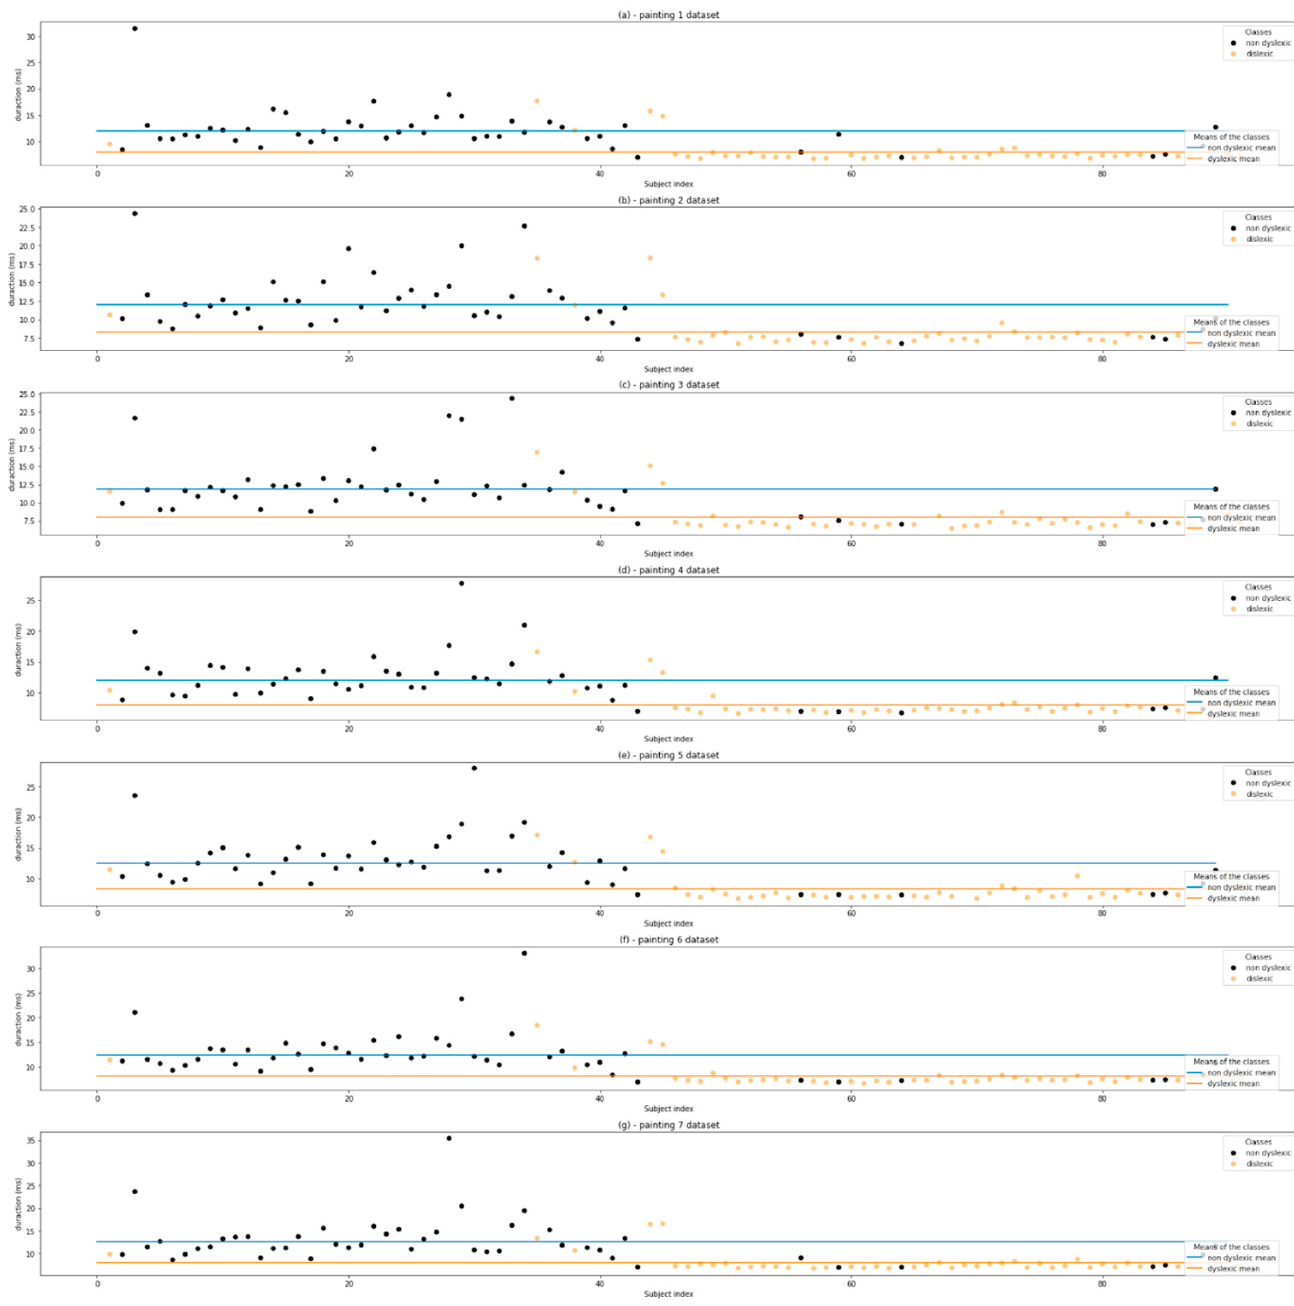
Figure A3. Duration. Subfigure ( a – g ) present the mean duration of the DGI segments for each patient for the Painting 1, 2, 3, 4, 5, 6, 7 Dataset, respectively.